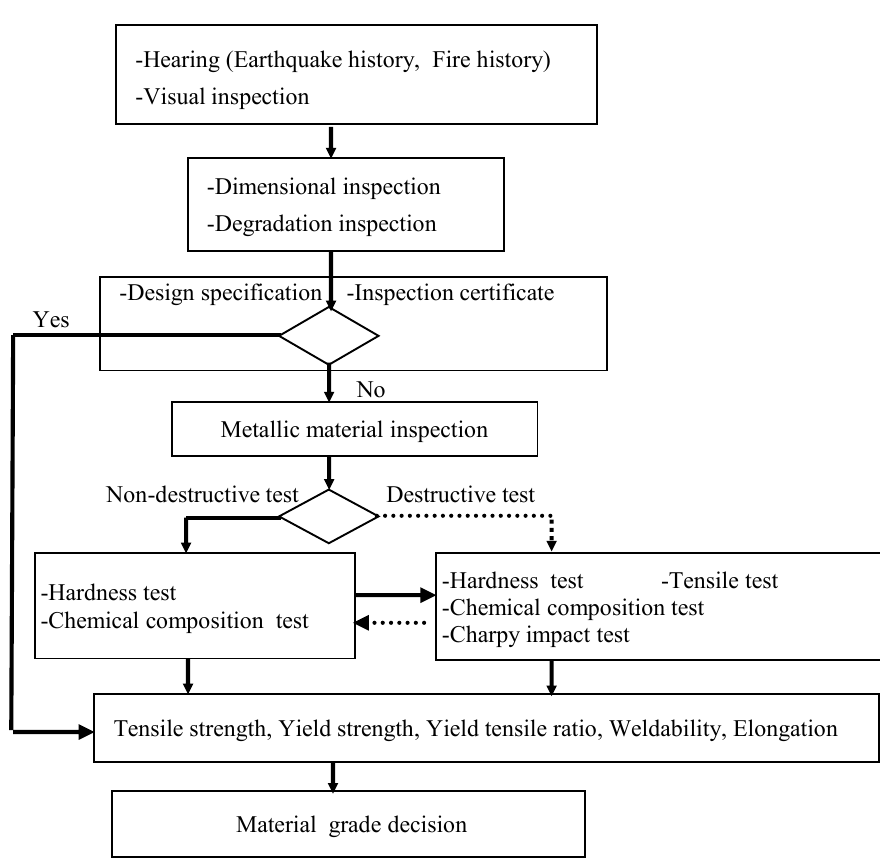
Figure 7. Evaluation flow of steel structural members for